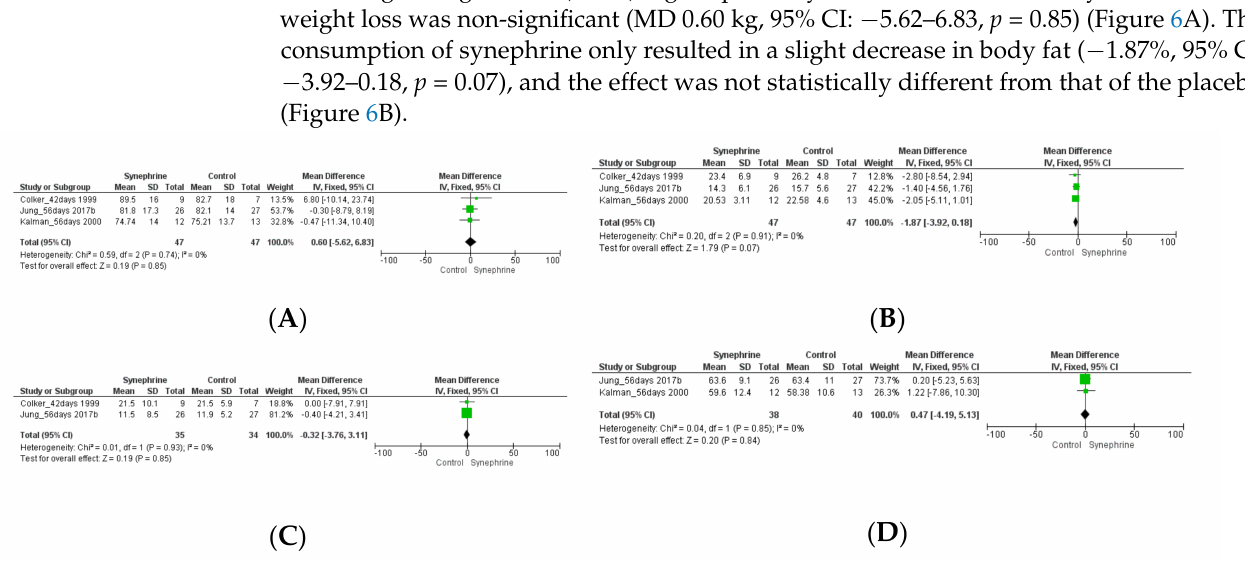
Figure 6. Forest plot diagram of synephrine on weight and body composition from (6–8 weeks) 42–56 days in intervention and control groups: ( A ) weight, ( B ) body fat, ( C ) fat mass, and ( D ) fat-free mass.